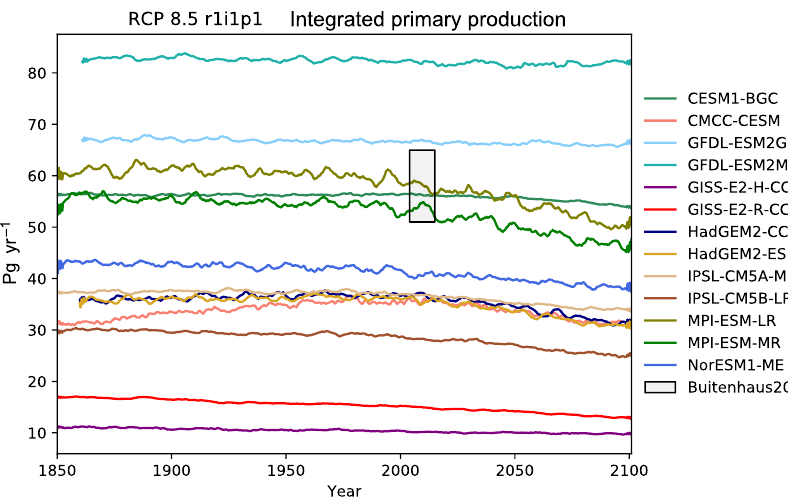
Figure 15. The total annual marine primary production of a range of